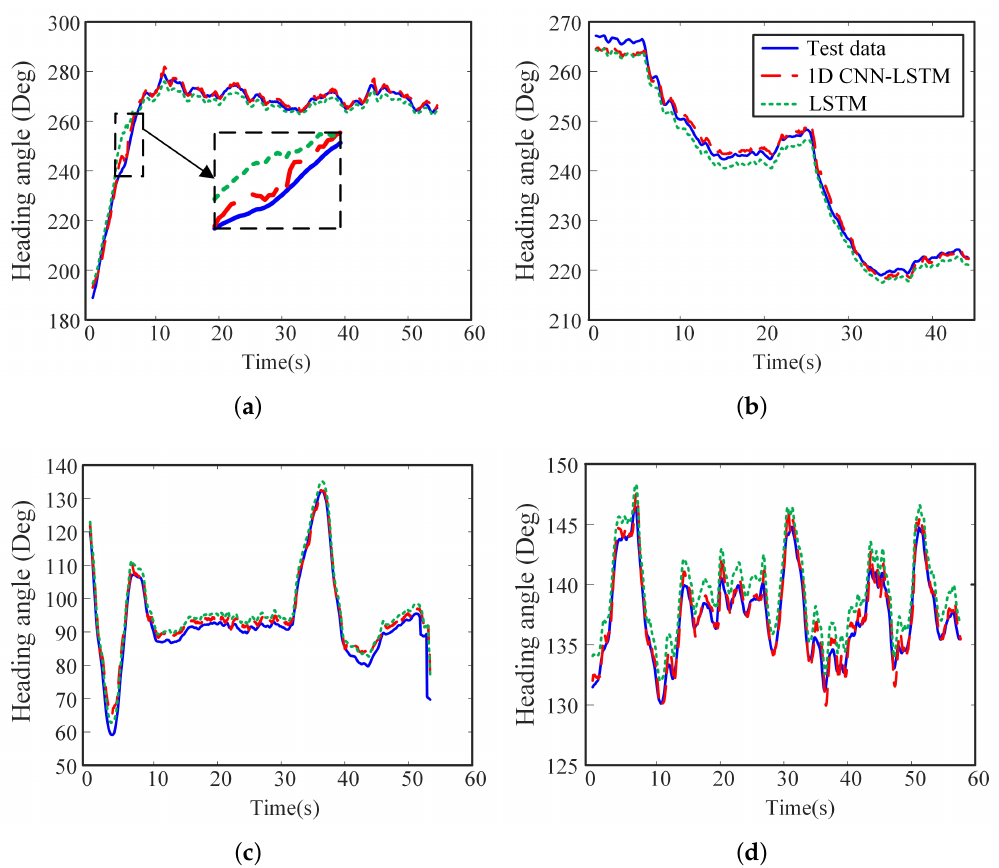
Figure 7. Comparison of the predict results and actual results by LSTM with CNN and LSTM without CNN at different sea level. ( a ) Level 1 sea condition. ( b ) Level 2 sea condition. ( c ) Level 3 sea condition. ( d ) Level 4 sea